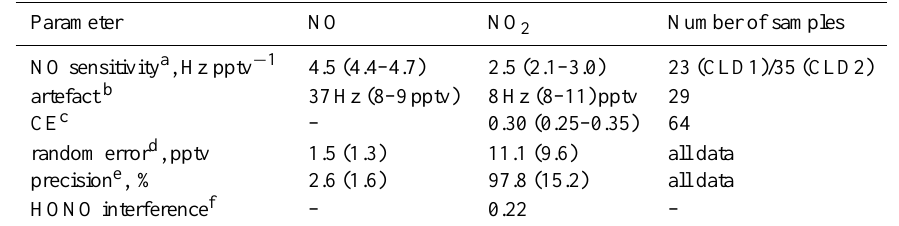
Table 1. Overview of parameters characterizing CLD instrument performance at Dome